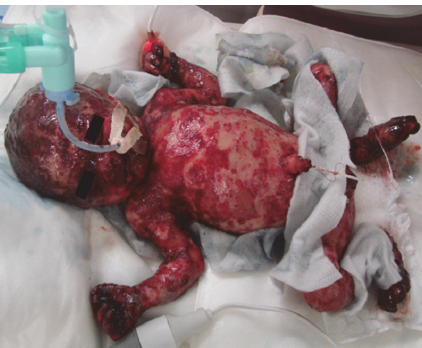
Figure 1: Photograph of the patient, showing extensive dissem- inated vesiculopapular cutaneous lesions. Hands and feet were contracted and